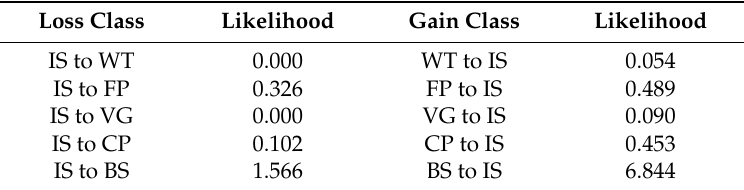
Table 7. The relative likelihood of land cover changes in Region 1 compared to Region 2 (IS, impervious surface; WT, water; FP, fishing ponds; VG, vegetation; CP, crop; BS, bare soil). All of the likelihoods were tested using χ 2 -test and found to have a p -value <